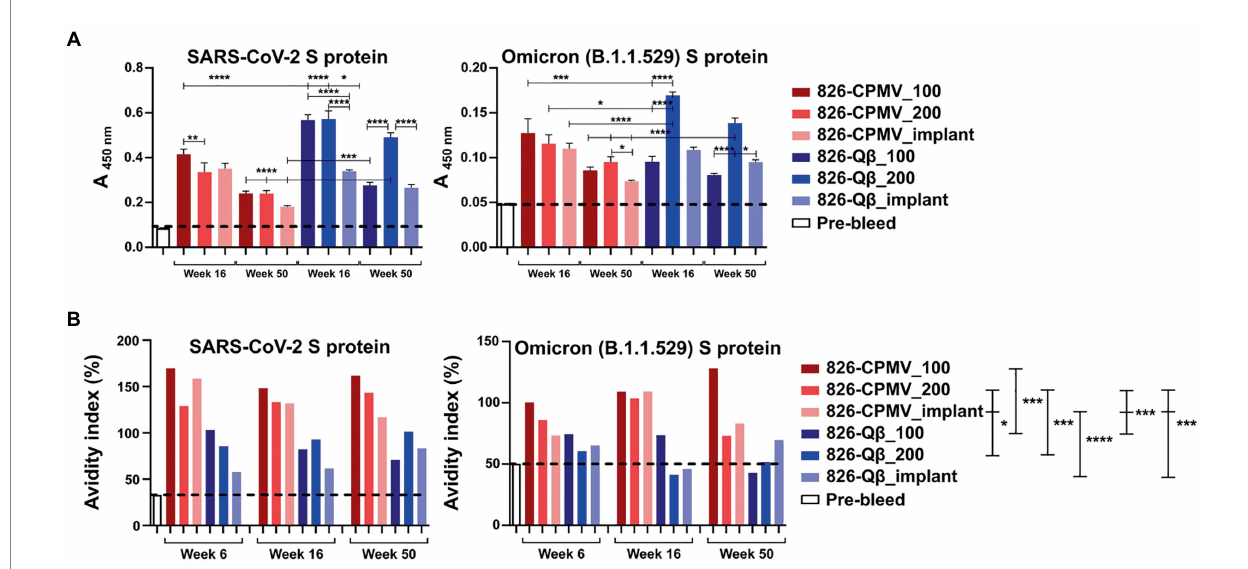
FIGURE 5 Analysis of antibody binding and avidity. (A) ELISA analysis of IgG binding to SARS-CoV-2 and Omicron (B1.1.529) S-proteins. Absorbance (450 nm) of pooled plasma from animals vaccinated with the different formulations. One-way analysis of variance (ANOVA) followed by Tukey’s multiple comparison test was used to compare between groups. (B) Avidity index of S-protein-specific IgG. The dashed line indicates the cutoff value. Two-way ANOVA using pairwise multiple comparison followed by Tukey’s multiple comparison test was used to compare between groups. Asterisks in the Support Information Supplementary Tables S4, S5 indicate significant differences between groups (* p < 0.05; ** p < 0.01, **** p <